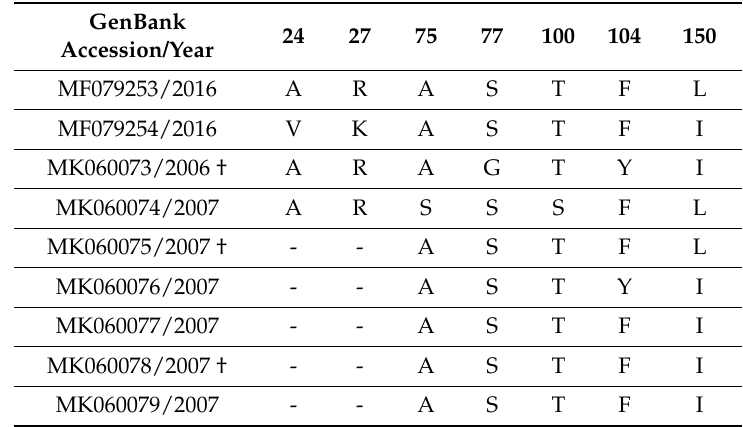
Table 1. Polymorphisms identified in the Porcine circovirus 3 (PCV3) Cap protein sequences of Brazilian strains from 2006 and 2007 and those recently collected in 2016. Each column corresponds to the positions of amino acid residues which are variable.